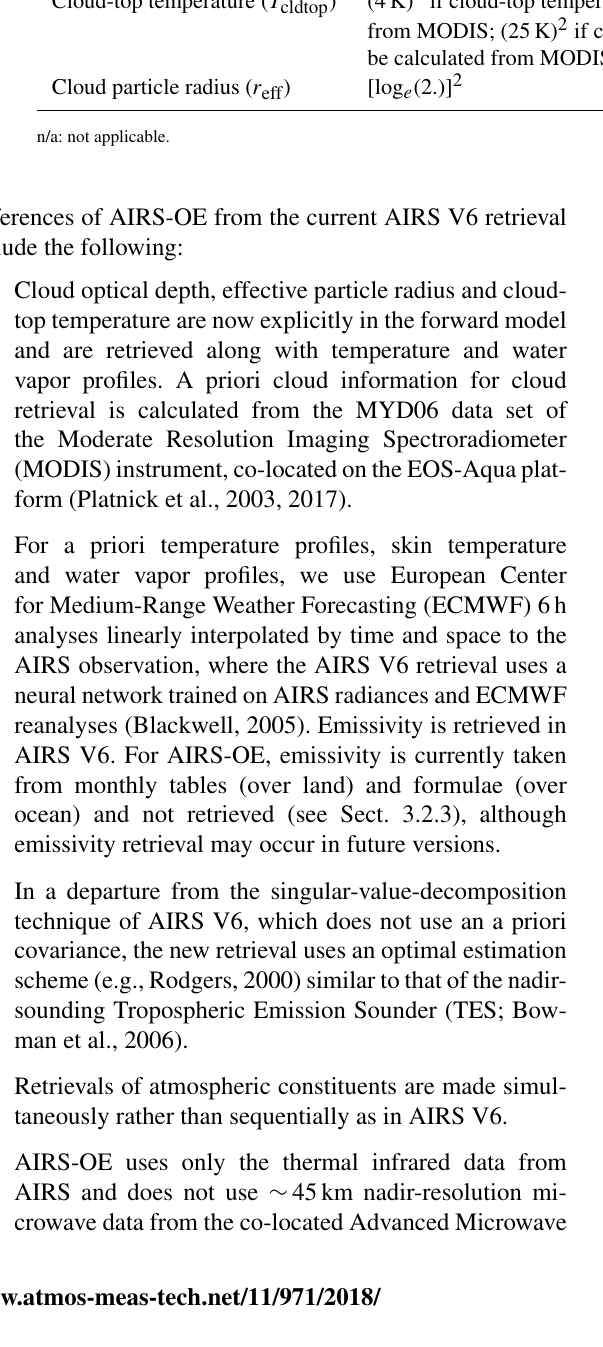
Table 1. A priori covariances used for retrievals. Constituent Covariance along diagonal Covariance Temperature profile ( T atm